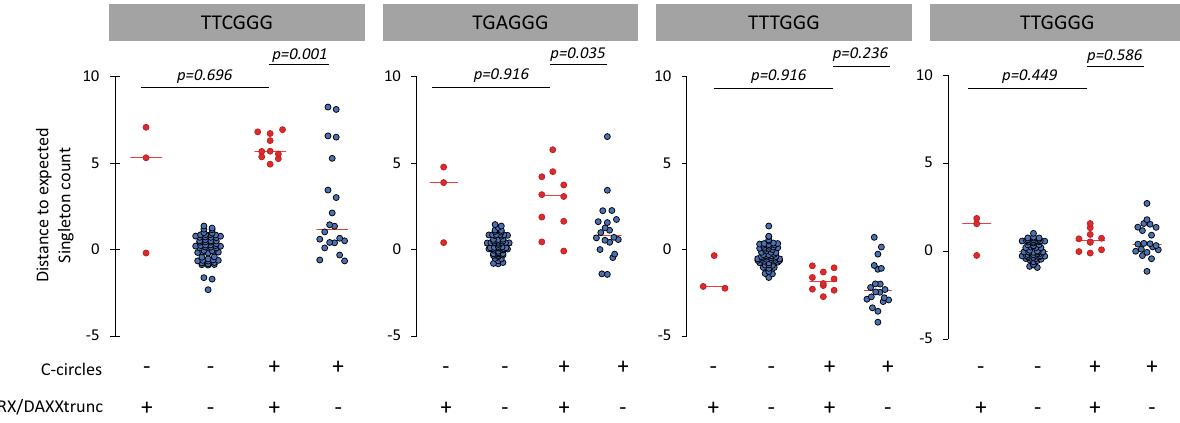
Fig. 2 Distance to the expected singleton repeat count in tumors with negative C-circle assay, with ( n = 3), or without ( n = 58) ATRX/DAXXtrunc, and in tumors with positive C-circle assay with ( n = 10), or without ( n = 20) ATRX/DAXXtrunc. The center (horizontal) red line of the scattergrams is the median. p < 0.05 was considered as signi fi cant; Kolmogorov – Smirnov tests,